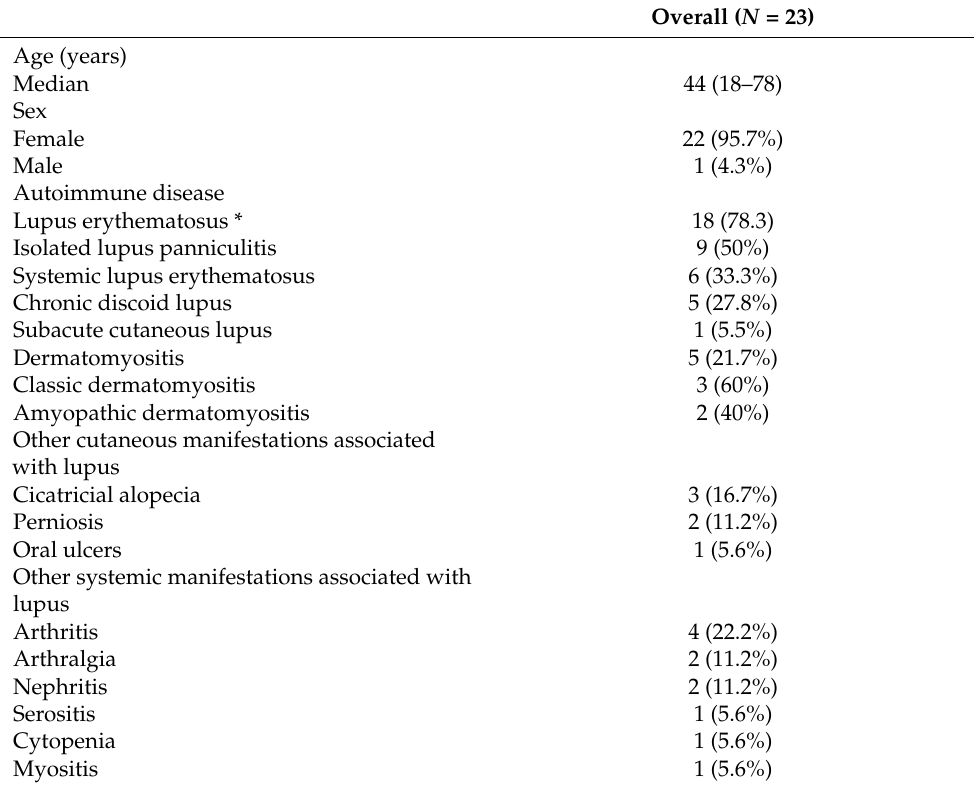
Table 1. Clinical characteristics of patients with connective tissue